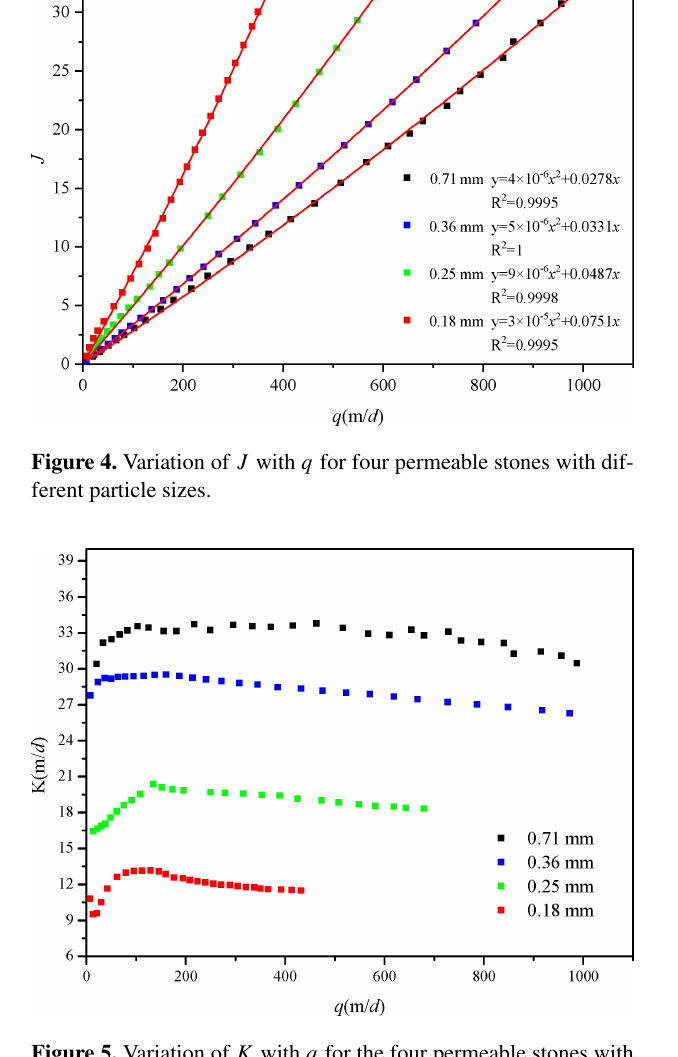
Figure 5. Variation of K with q for the four permeable stones with different particle